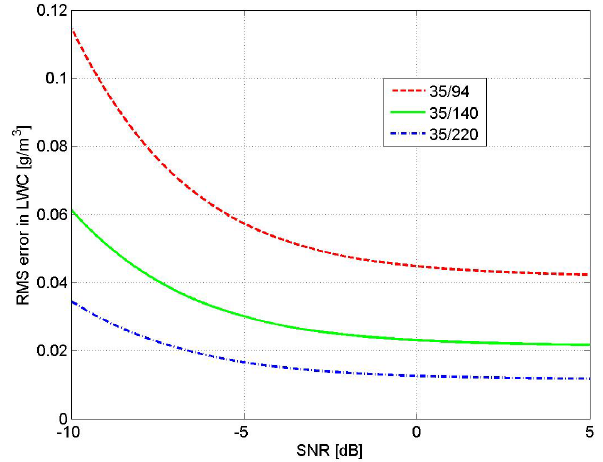
Figure 5. Errors in retrieved LWC using 35/94GHz, 35/140GHz Fig. 5. Errors in retrieved LWC using 35/94GHz, 35/140GHz and 35/220GHz radar frequency pairs vs. the and 35/220GHz radar frequency pairs vs. the single-pulse signal- single-pulse signal-to-noise ratio. A vertical resolution of 150 m (2 gates), a one minute dwell time, T = 10 ◦ C, to-noise ratio. A vertical resolution of 150m (2 gates), a one minute a spectral width of 0.3 ms − 1 and a pulse repetition frequency of 6250 Hz at all frequencies have been assumed. dwell time, T = 10 ◦ C, a spectral width of 0.3m s − 1 and a pulse repetition frequency of 6250Hz at all frequencies have been as-